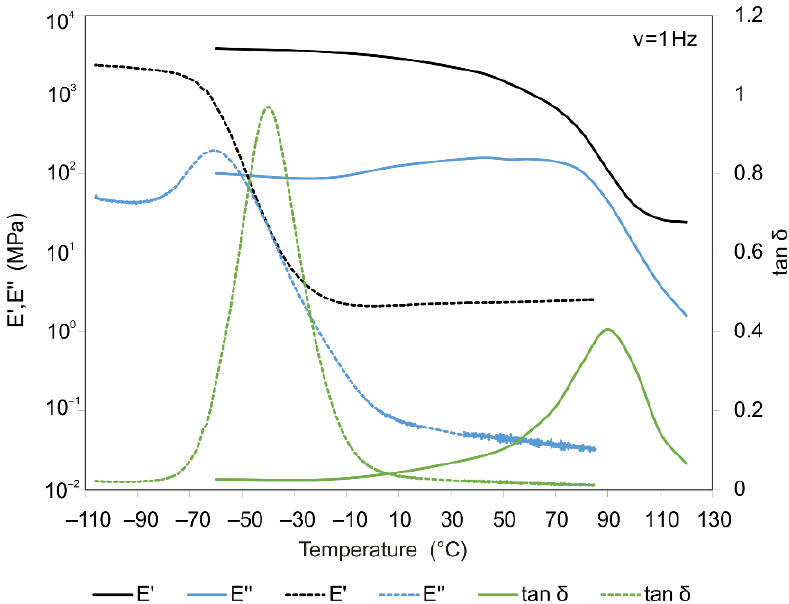
Figure 1. Results of dynamo-mechanical analysis of DeSolite 3471-1-152A (dashed line) and DeSolite DS-2015 (solid line) polymers, frequency 1 Hz, heating rate 2 °C/min.